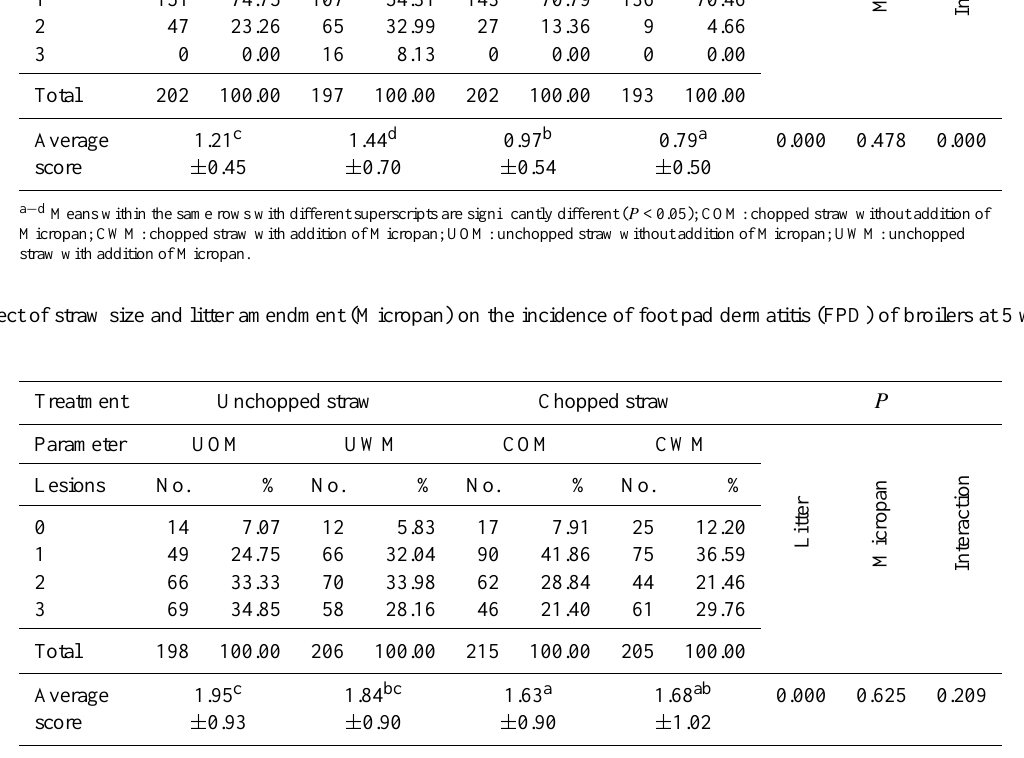
a − c Means within the same rows with different superscripts are significantly different ( P <0.05); UOM: unchopped straw without addition of Micropan; UWM: unchopped straw with addition of Micropan; COM: chopped straw without addition of Micropan; CWM: